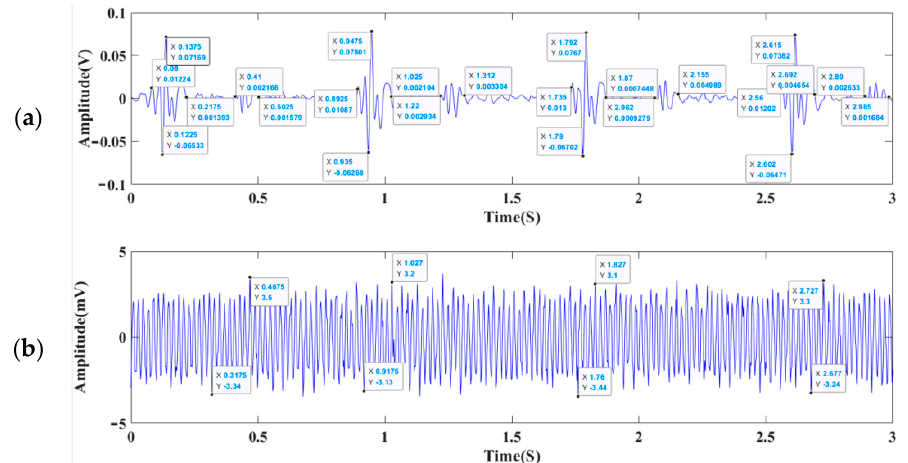
Figure 17. ( a ) The cardiac sound test results of the MEMS cardiac sound sensor. ( b ) The static noise of the MEMS cardiac sound sensor. Table 4. Heart-sound signal test